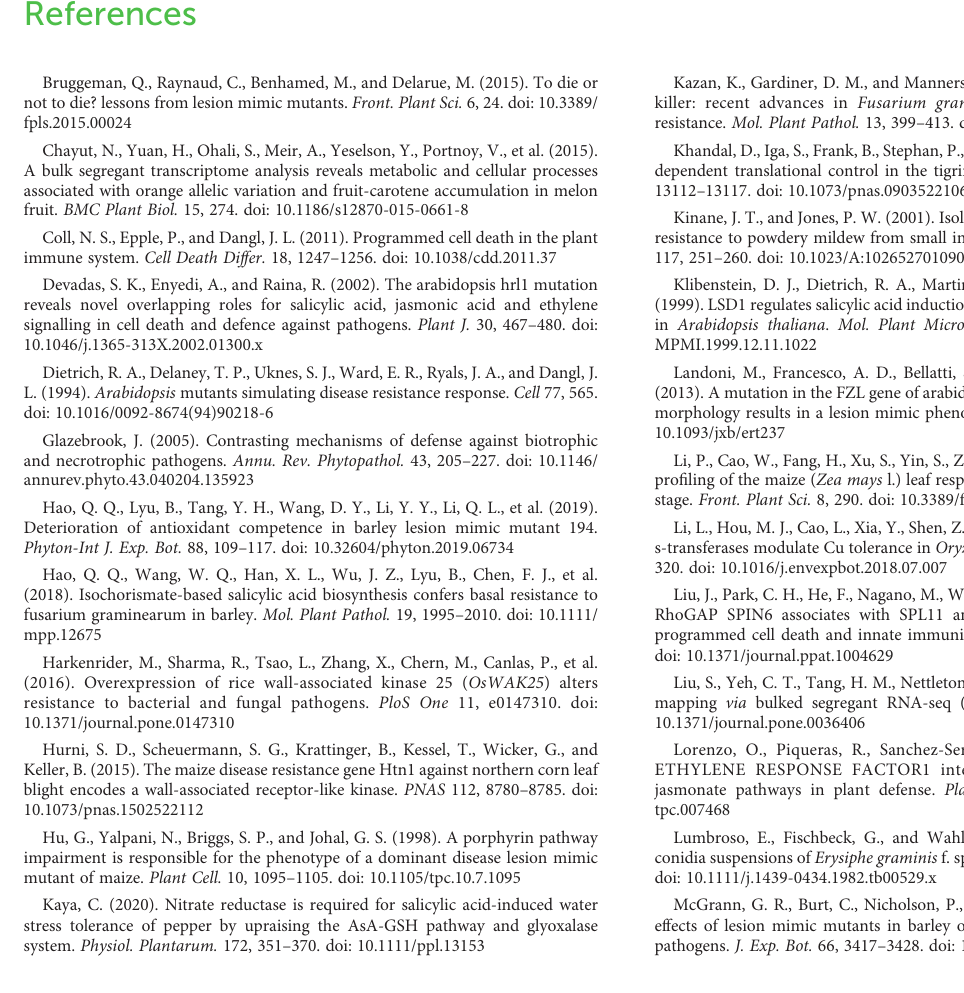
SUPPLEMENTARY FIGURE 1 BSR-Seq analysis SNPs and InDels of lesion mimic 5386/Morex F2 population.